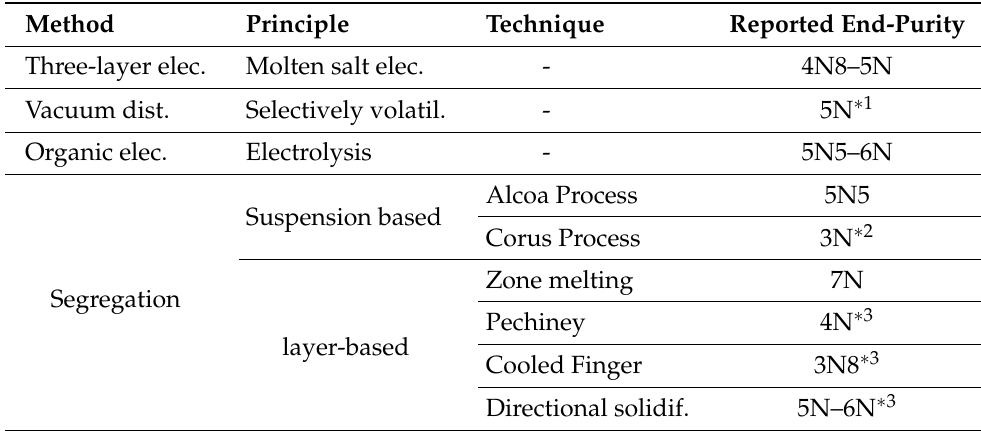
Table 8. Comparison of methods for high-purity aluminum